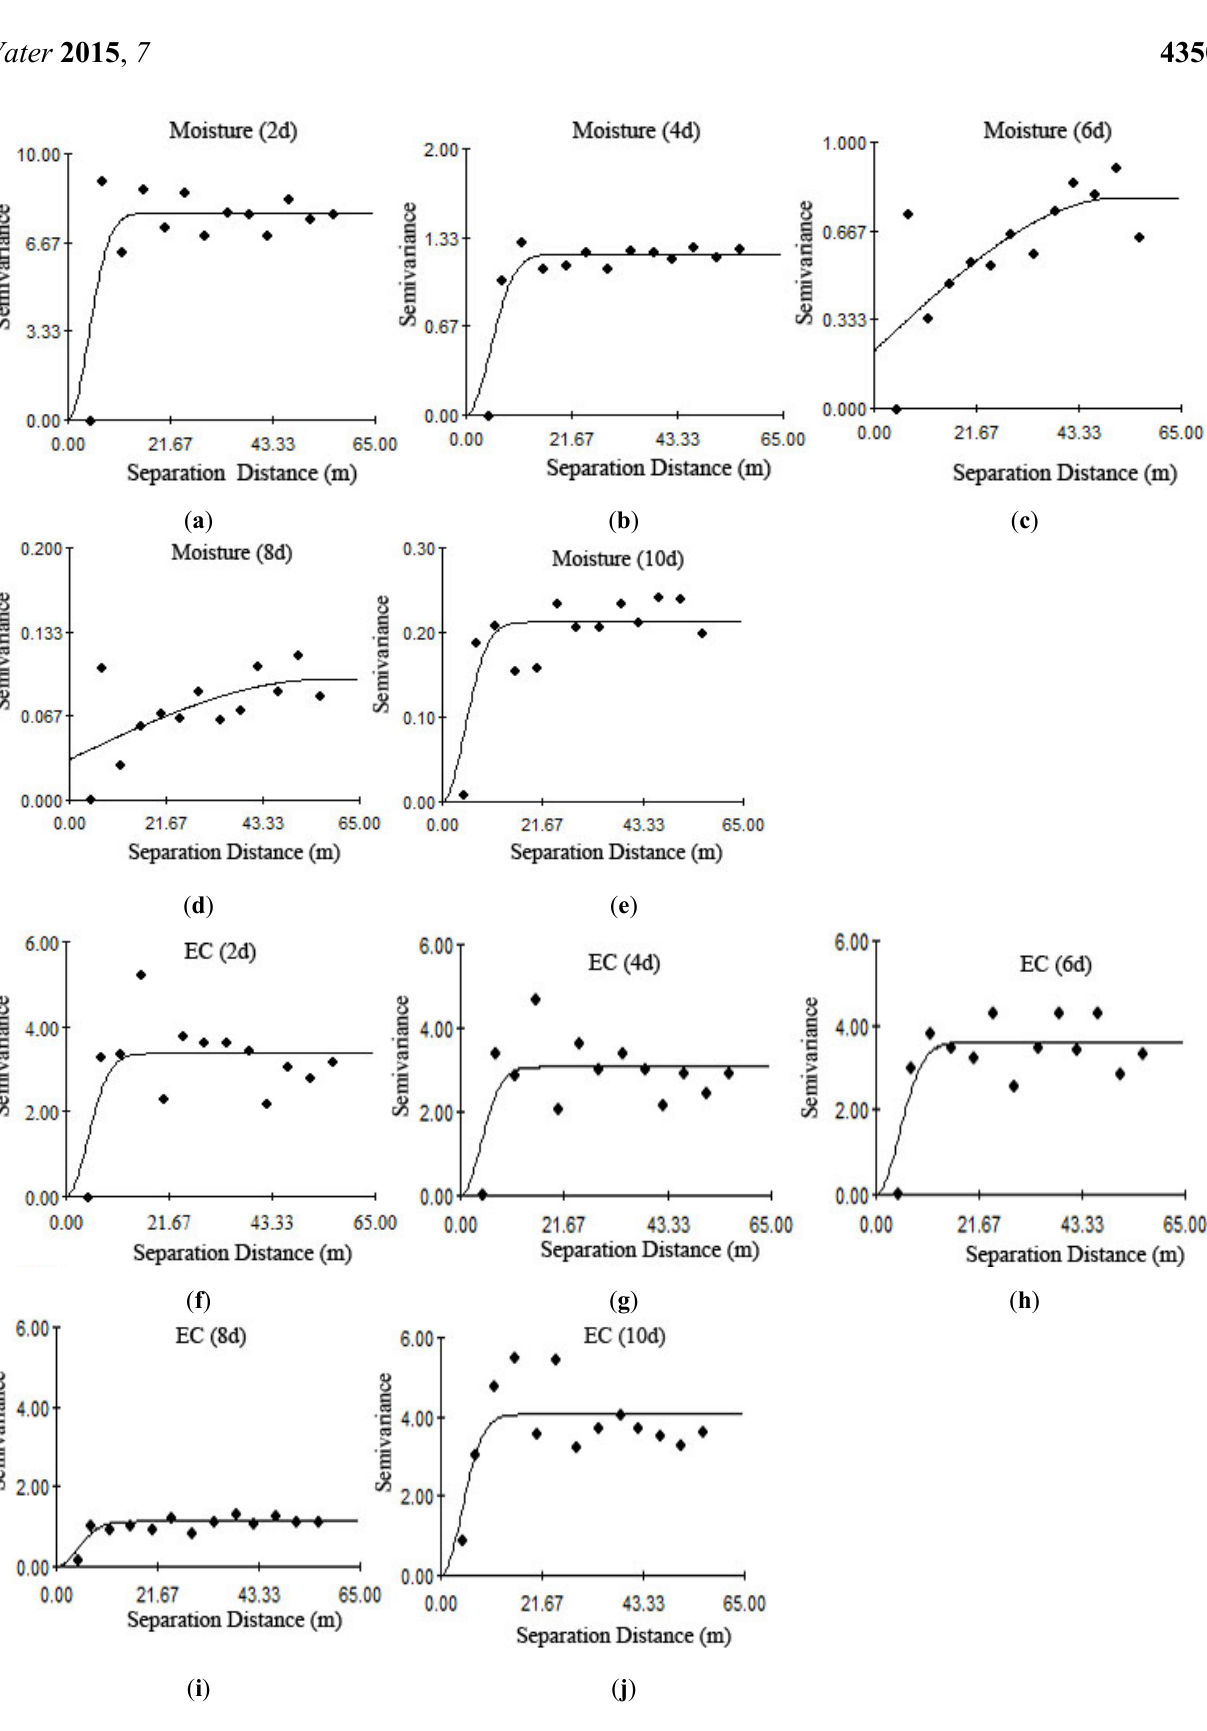
Figure 2. Values of moisture ( a – e ) and EC ( f – j ) variograms of all plots during one irrigation cycle in July. 2d, 4d, 6d, 8d, 10d represent 2nd, 4th, 6th, 8th, and 10th days after